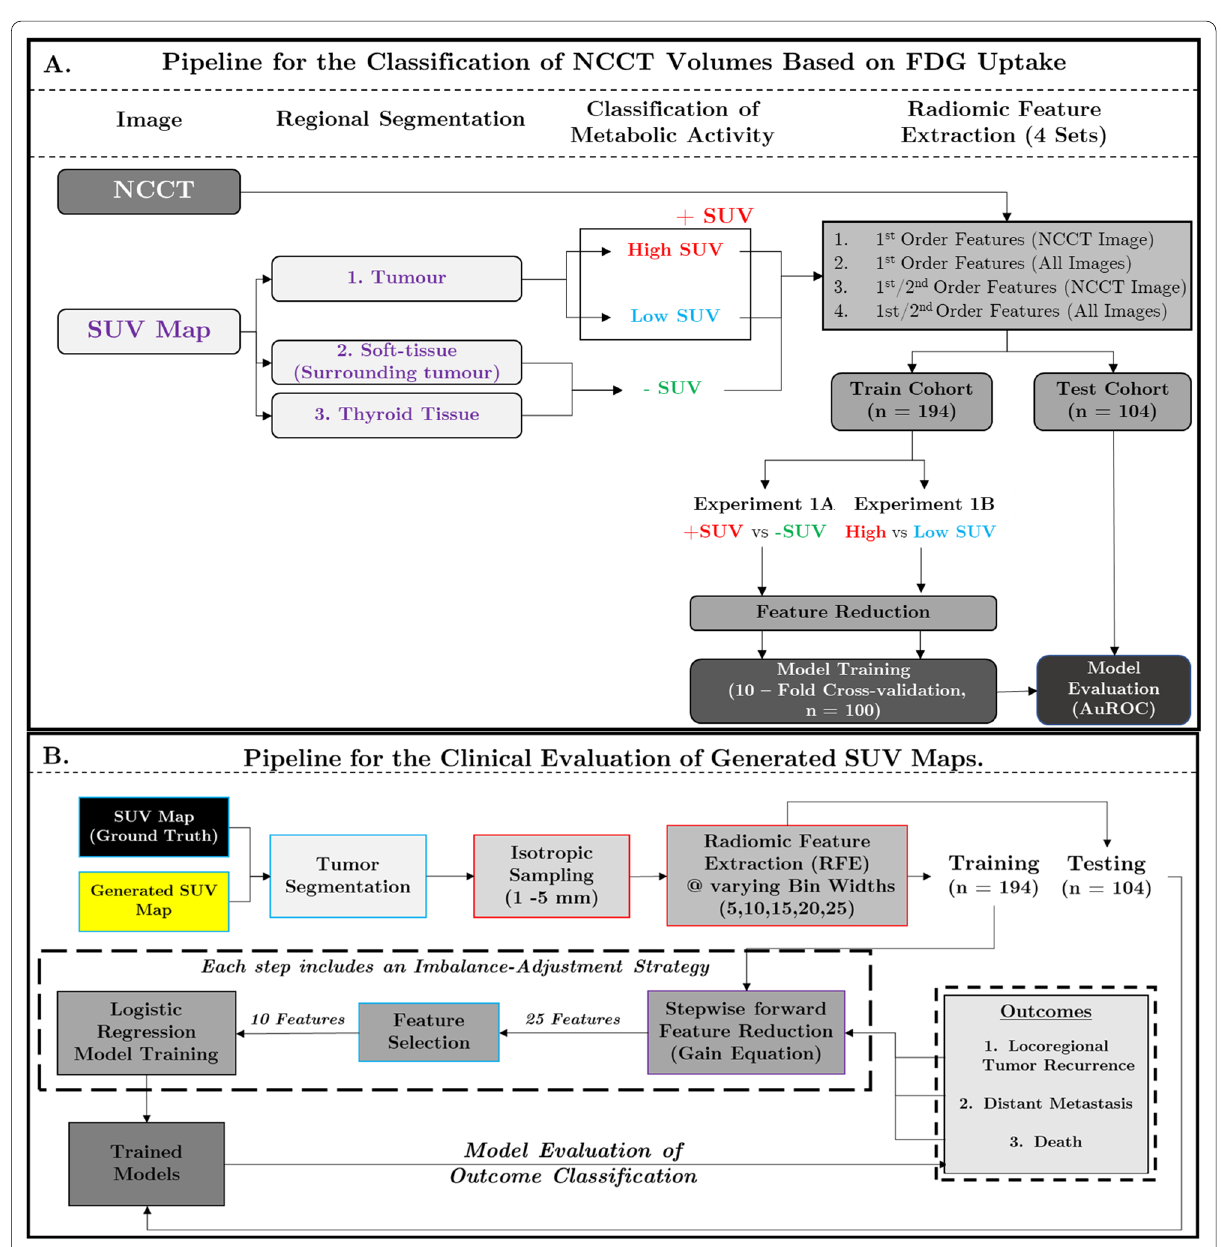
Fig. 1 a Workflow for the classification of volumes extracted from non-contrast CT images based on FDG uptake using radiomic signature (Experiments 1A and 1B). Tumour and adjacent soft tissue were segmented from the SUV map using threshold-based methods and the thyroid tissue was manually segmented on the paired/registered non-contrast CT image. Volumes were classified based on FDG uptake into three categories (High SUV, Low SUV, and negligible SUV). High/Low SUV were localised within the tumour volume (0.50 Max SUV). Regions of × negligible SUV included the soft tissue surrounding the tumour and thyroid tissue. Four sets of radiomic features were extracted within the segmented volumes from either the CT image or All Images (NCCT Filtered Images). Filtered images included the CT image with applied + Laplacian of Gaussian and Wavelet filters. Full details regarding image filtering can be found within the supplement. Feature reduction was performed in MATLAB using the minimum redundancy, maximum relevance (MRMR) algorithm. Tenfold cross-validation was performed ( n 100) = and each of the validated models was applied on the testing cohort. b Pipeline for the Clinical Evaluation of Simulated SUV Maps. This pipeline is based on the work performed by Vallières et al. which focused on the application of SUV maps for the prediction of three clinical outcomes: (1) Locoregional tumour recurrence, (2) Distant Metastasis and (3) Death. The pipeline consists of radiomic feature extraction from the tumour regions within the SUV Map. Feature reduction, selection and model training were performed on the training cohort using an imbalance-adjustment strategy that was identical to Vallieres et al. Optimised models were evaluated on the testing